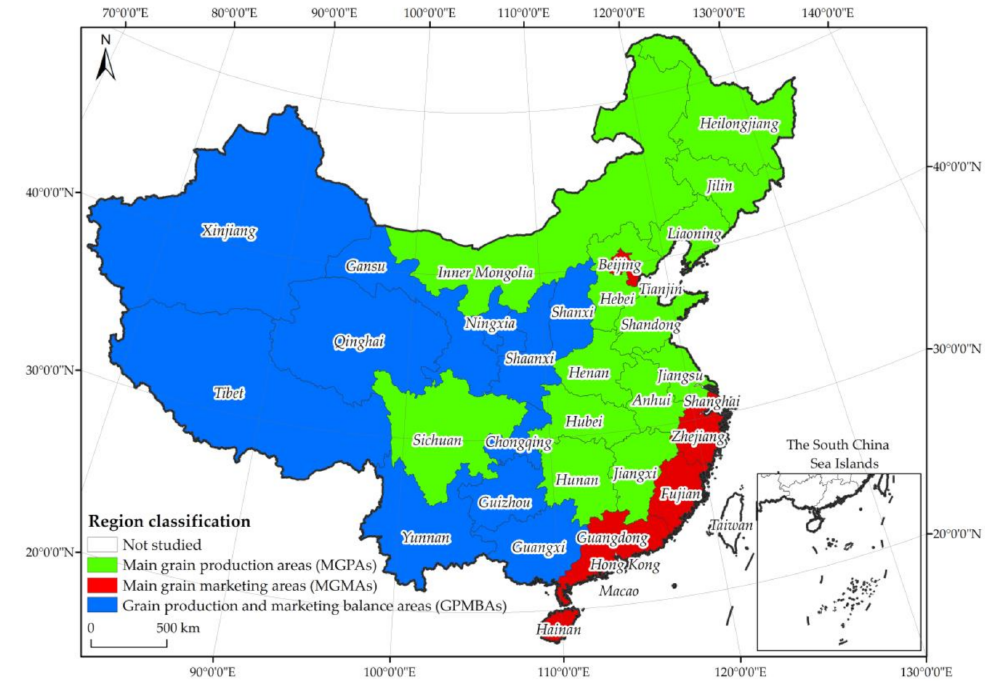
Figure 1. Research scope and regional